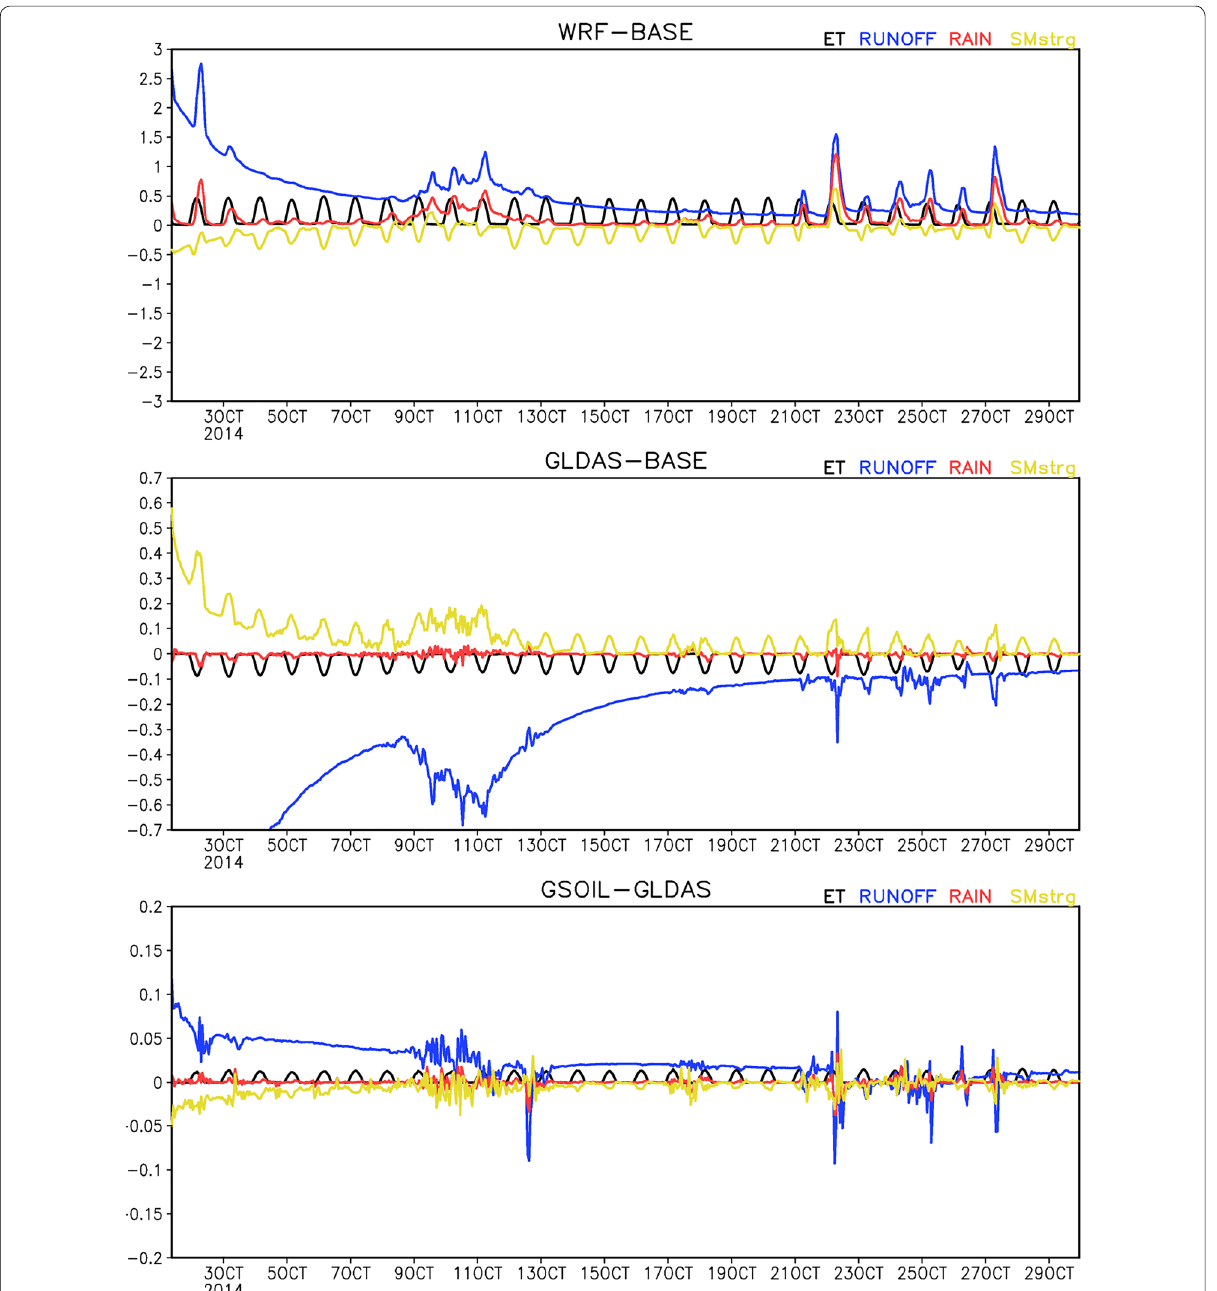
Fig. 9 Hourly variations of individual processes in surface water budget equation (mm/h) averaged from simulation domain. Top to the bottom, from WRF‑base run, difference between WRF‑GLDAS and WRF‑base and difference between WRF‑GSOIL and WRF‑GLDAS (yellow line: change in soil water storage; red line: precipitation; black line: evapotranspiration; and blue line: total